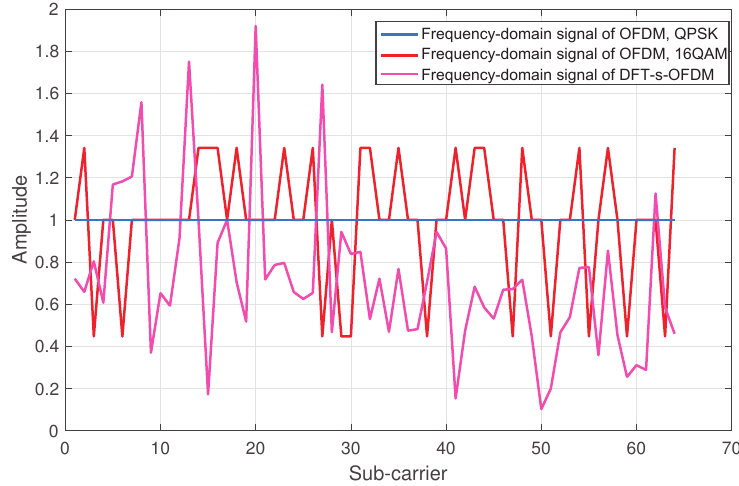
Figure 5. Comparison of OFDM signal under different